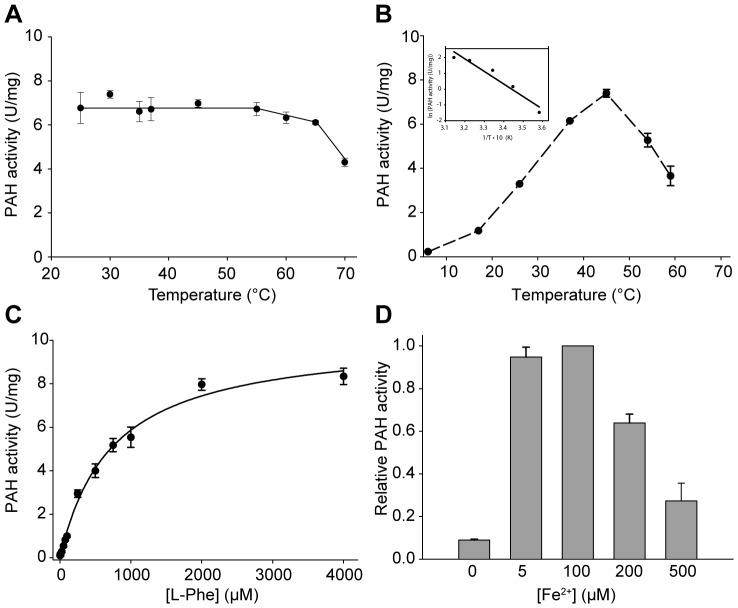
Steady-state kinetic characterization of lpPAH.(A) Residual activity at 37°C after incubation for 10 min at the indicated temperatures. (B) Temperature dependence of lpPAH activity. Inset, Arrhenius plot (providing an activation energy (E
a) of 15.8±2.3 kcal/mol). (C) Effect of L-Phe concentration on lpPAH activity, measured with 0.2 mM BH4 and 100 µM Fe(II). The solid line is a fitting to the Michaelis-Menten equation. (D) Effect of Fe(II)-concentration on lpPAH activity, measured with 1 mM L-Phe and 0.2 mM BH4. One enzyme unit (U) corresponds to the amount of enzyme that catalyzes the production of 1 µmol L-Tyr per minute.